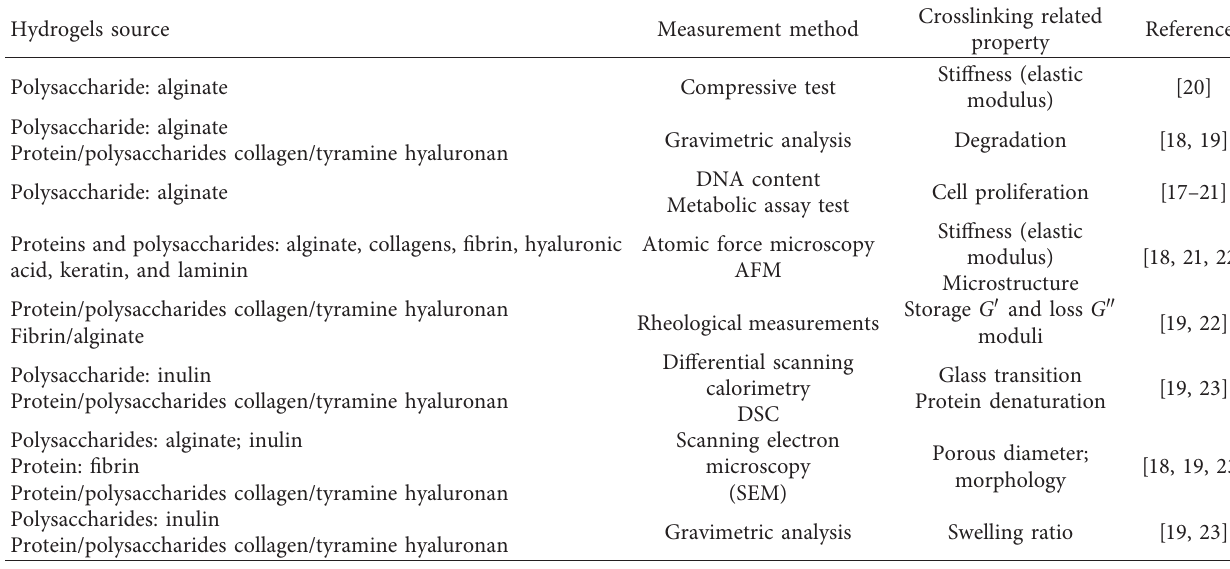
Table 1: Protein and polysaccharide derivates hydrogels crosslinking related properties